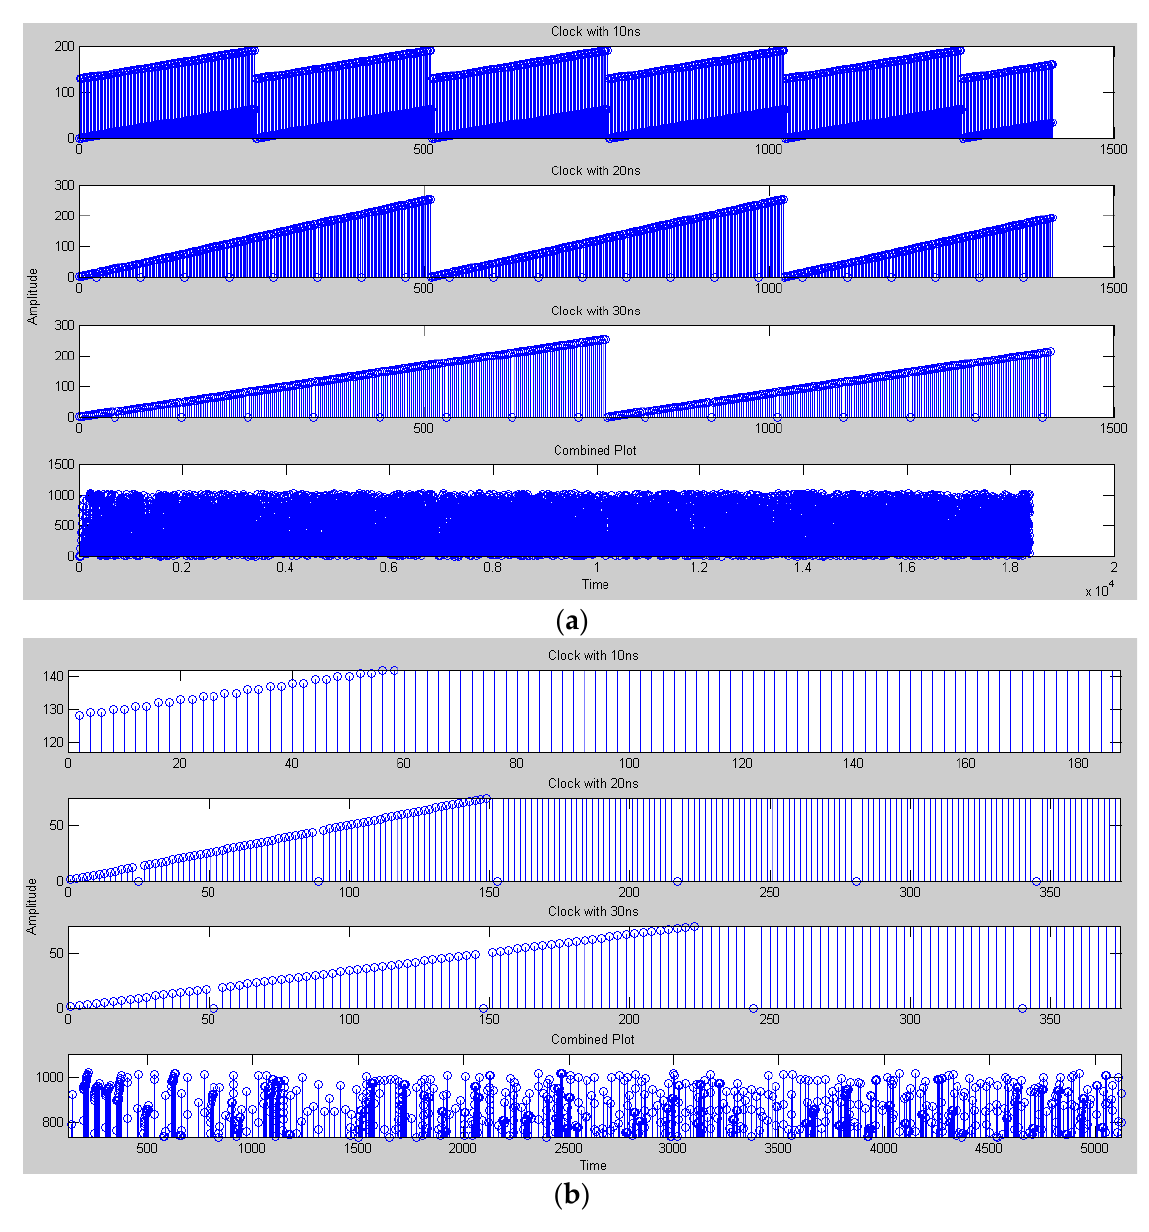
Figure 12. ( a ) Communication between PEs with delays and miss bit errors − Simple view. ( b ) Com- munication between PEs with delays and miss bit errors − Expanded view.